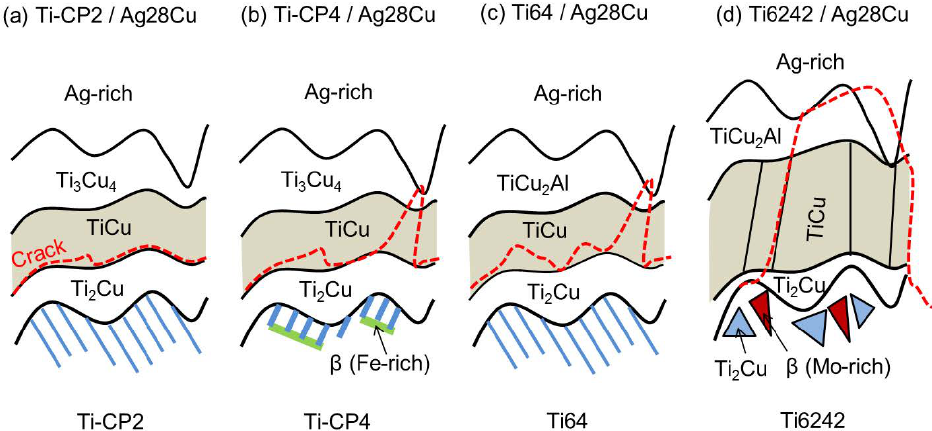
Figure 10. Schematic representation of the different failure modes found for the different brazing systems: Ti-CP2/Ag28Cu ( a ), Ti-CP4/Ag28Cu ( b ), Ti64/Ag28Cu ( c ), Ti6242/Ag28Cu ( d ). The crack paths are indicated by dashed red lines.